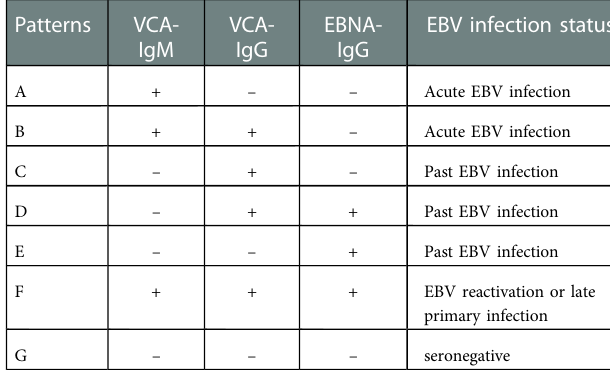
TABLE 1 Common EBV antibody